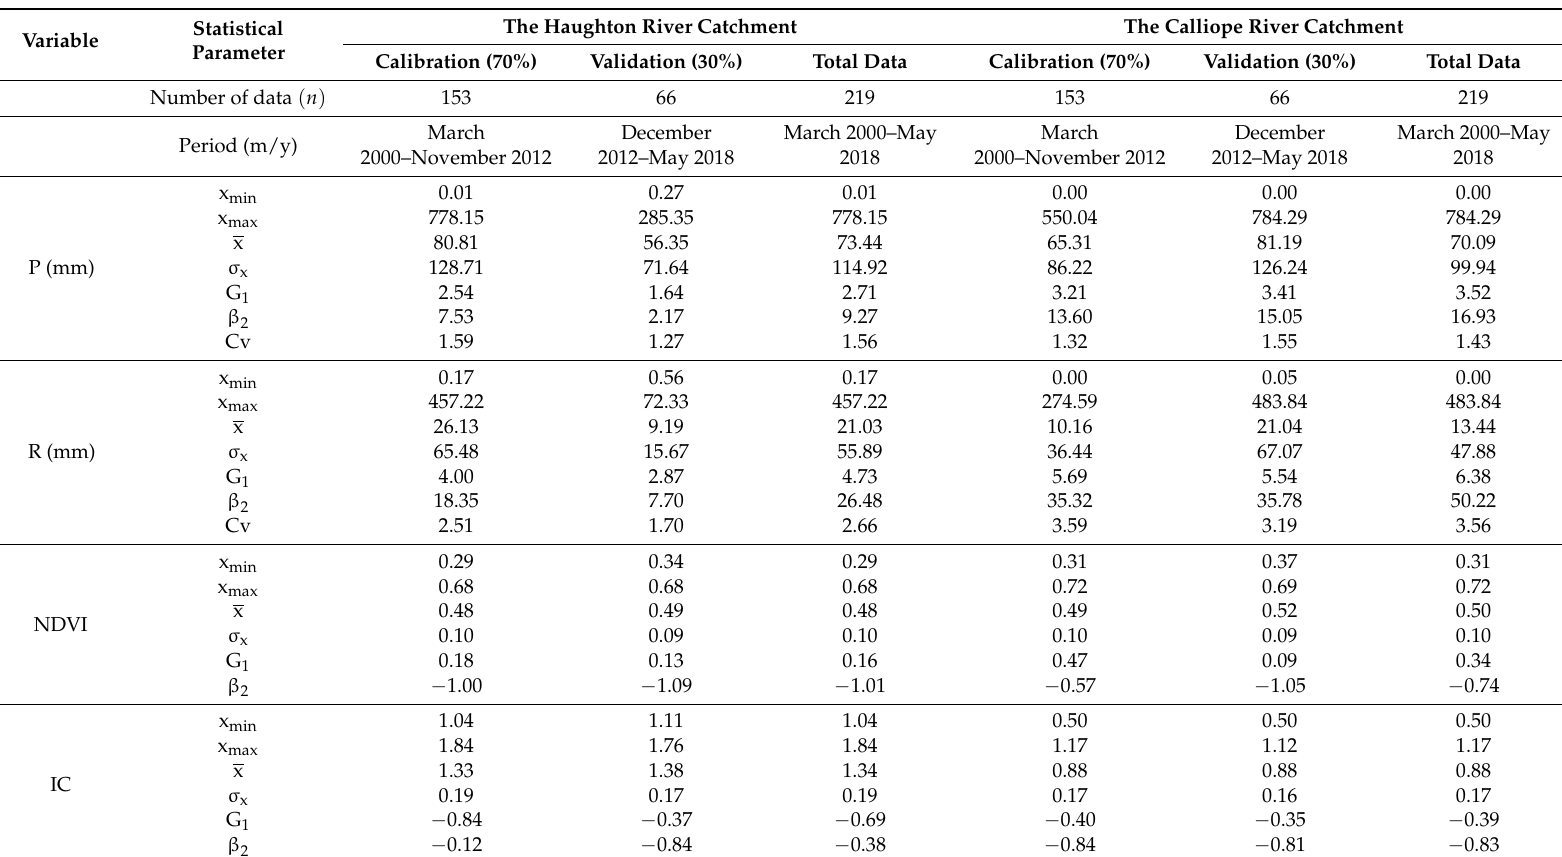
Table 2. Statistical parameters of monthly rainfall, runoff, Normalized Difference Vegetation Index (NDVI) and Index of Connectivity (IC) for the total, calibration and validation datasets for studied catchments.